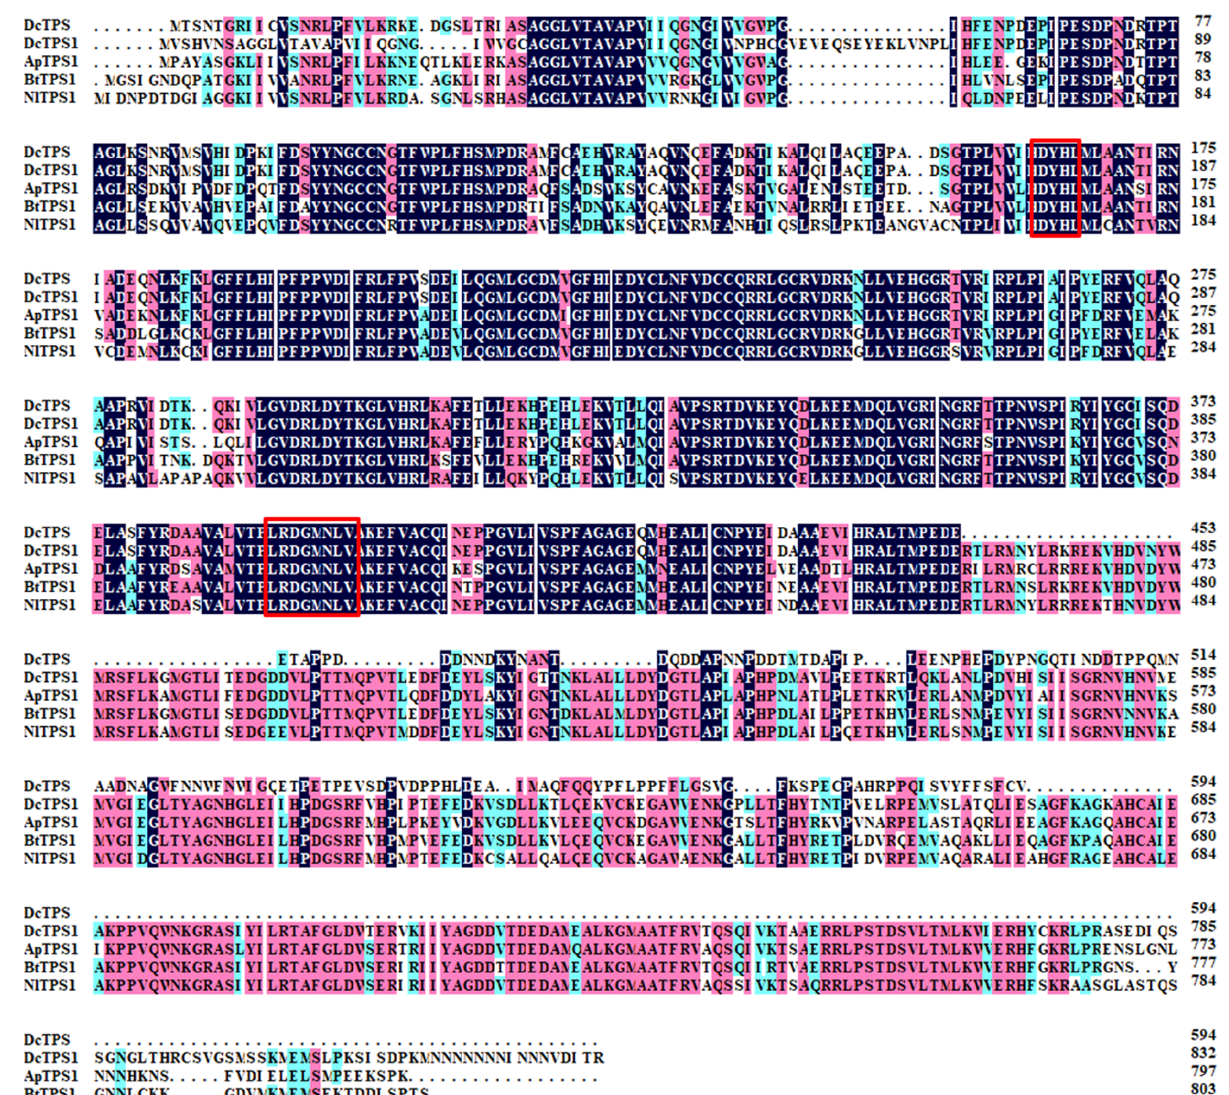
Figure 2. Multiple sequence alignment of the conserved domain of the TPS1 from four insect species, including Diaphrina citri TPS1 (MZ888936), Diaphorina citri TPS (QOU11567), Acyrthosiphon pisum TPS1 (XP_001945523), Bemisia tabaci TPS1 (XP_018916964) and Nilaparvata lugens TPS1 (ACV20871). Signature motifs (HDYHL and DGMNLV) unique to TPS was presented with red box. The conserved amino acid residues are highlighted in black, and similar amino acid residues are labelled in pink and blue.